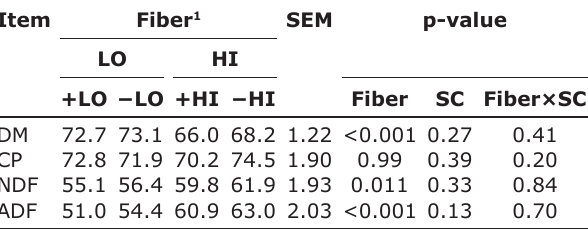
Table-3: Effect of SC supplementation in Awassi female lambs fed with LO- and HI-fiber diets on nutrient digestibility